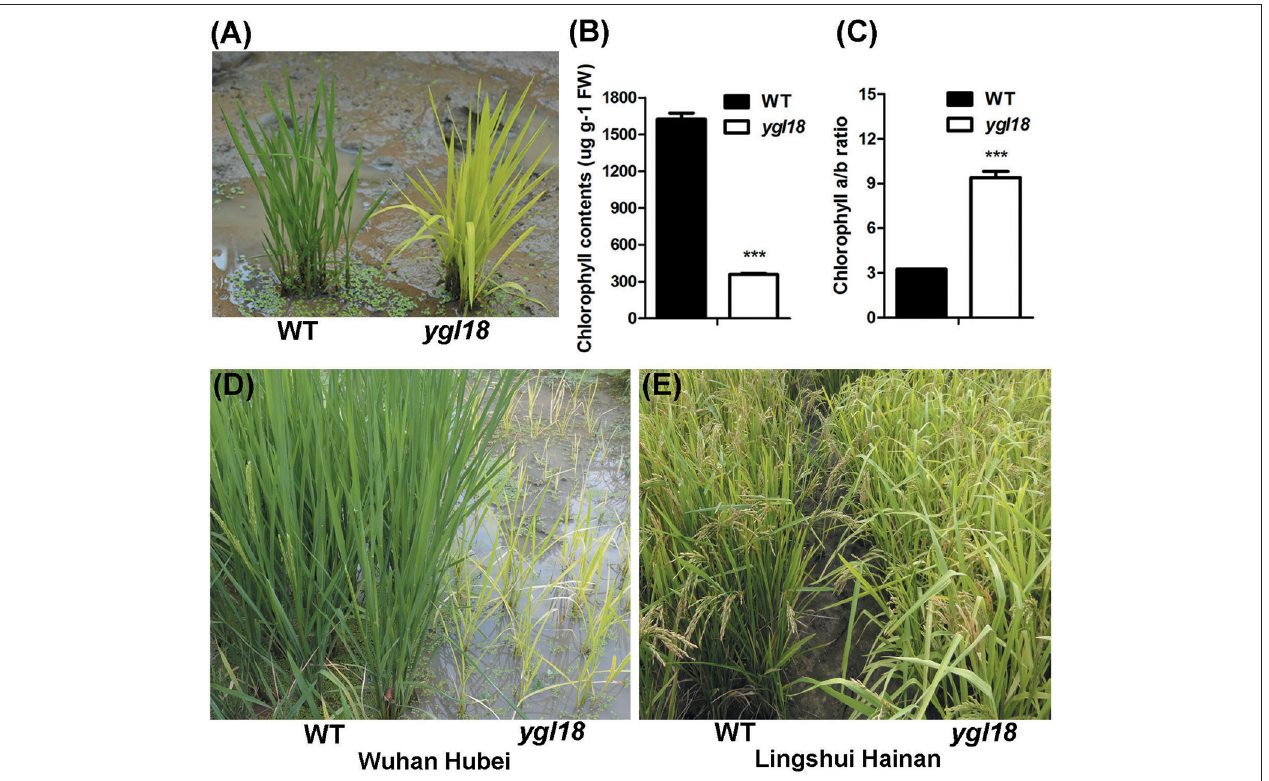
FIGURE 1 | Phenotypic characterization of the wild-type and ygl18 mutant plants. (A) Plants at the seedling stage (about 15 days old) in the paddy field. (B) Chlorophyll contents. FW, fresh weight. (C) Chlorophyll a / b ratio. (B,C) Data represent the mean ± SD of three biological replicates (Student’s t -test: *** P < 0.0005). (D) Plants growing in a natural field in Wuhan of Hubei province in China. (E) Plants growing in a natural field in Lingshui of Hainan province in